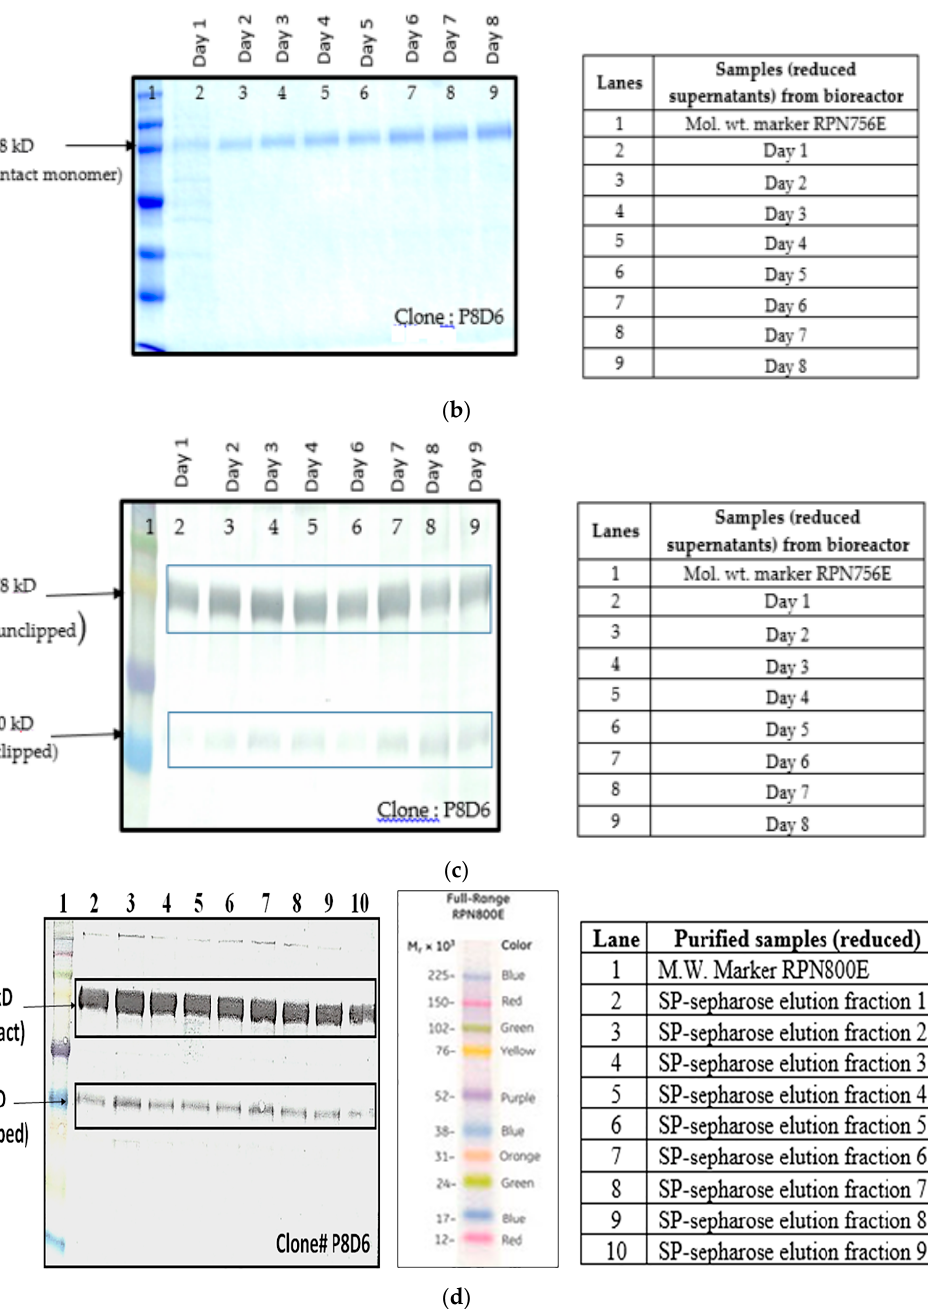
Figure 4. ( a ) SDS-PAGE of supernatant samples of bioreactor culture on various days (non-reduced); ( b ) SDS-PAGE of supernatant samples of bioreactor culture on various days (reduced); ( c ) Western blot of samples from bioreactor (reduced); ( d ) Western Blot of VEGFR1(D1–D3)-Fc purified fractions from SP-Sepharose cation exchange chromatography (reduced samples).